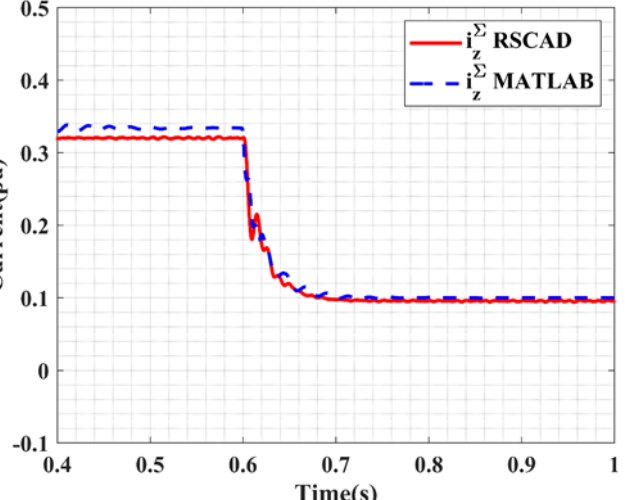
Figure 7. Comparison of the zero sequence circulating current ( i Σ z ) in MATLAB (blue) and RSCAD (red), during step change in active power from 1 p.u. to 0.3 p.u. at the time instance t = 0.6 s. Reactive Power Step